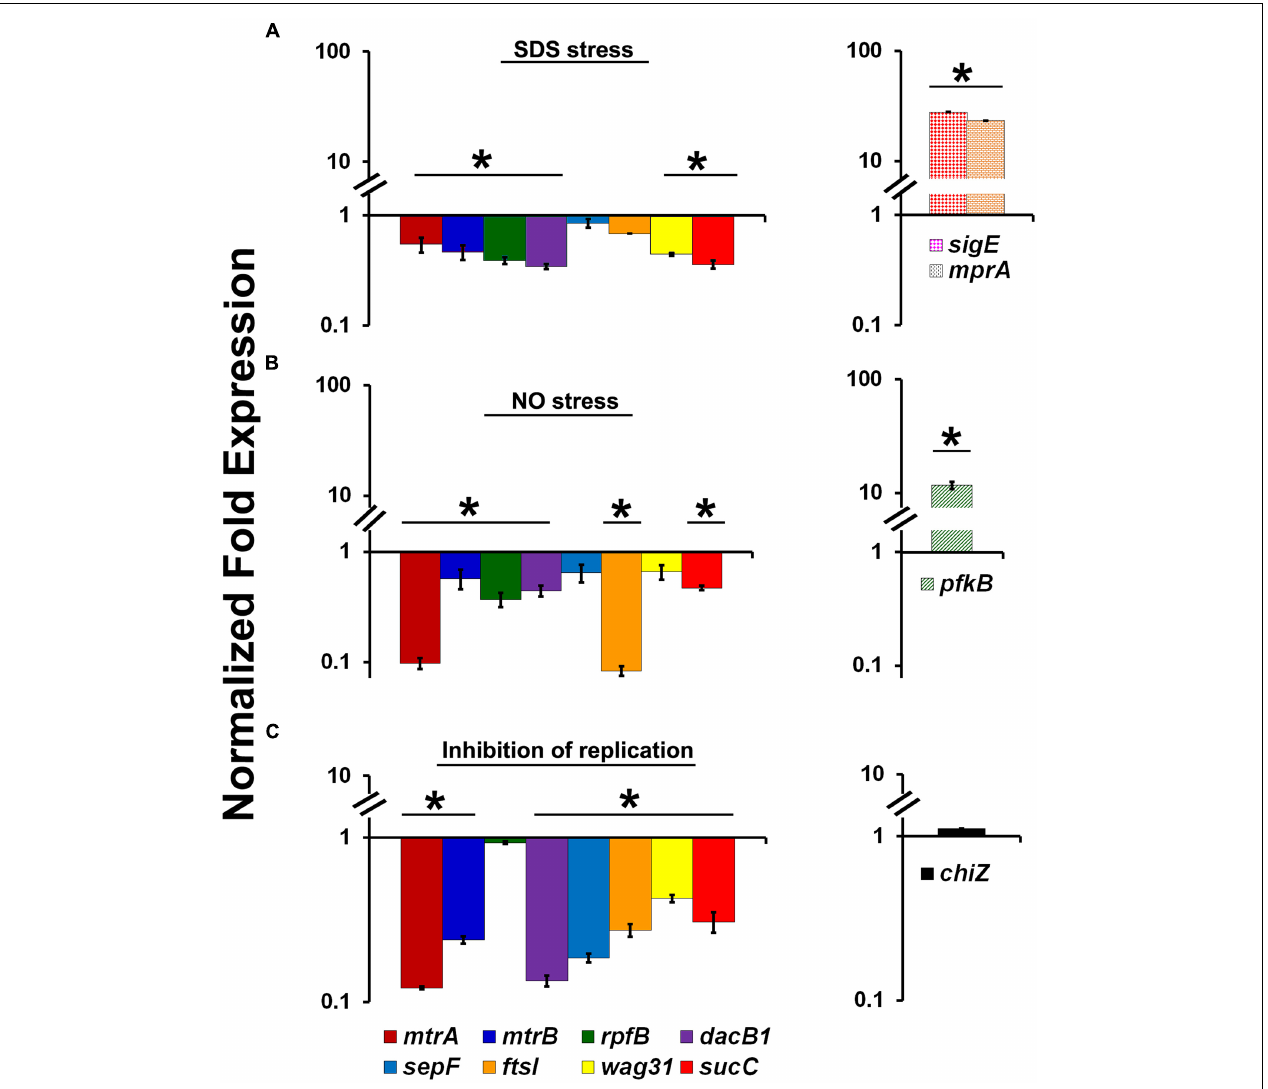
FIGURE 3 | Expression profiles of select MtrA target genes ( mtrA, mtrB , rpfB , dacB1 , sepF, ftsI , wag31, and sucC ) under stress and replication-arrest conditions. (A) Total RNA was extracted from actively growing M. tuberculosis cultures exposed to 0.2% SDS for 2 h and the expression levels were analyzed by qRT-PCR as described in Section “Materials and Methods.” (B) Total RNA was extracted from actively growing M. tuberculosis cultures exposed to 100 µ M DETA-NO for 16 h and qRT-PCR was performed to analyze gene expression profiles. (C) For evaluating the MtrA-target expression under replication inhibition conditions, M. tuberculosis dna A Ts cultures growing at permissive 37 ◦ C were shifted to 30 ◦ C and incubated for 30 h (non-permissive temperature). RNA samples prepared from cultures growing at both permissive and non-permissive temperatures were processed for evaluation of the target gene expression using qRT-PCR approach. The expression levels of selected genes at non-permissive temperature referred “Inhibition of replication” condition, relative to permissive temperature (37 ◦ C) are present on the graph. The qRT-PCR data are normalized to 16S rRNA levels. Mean values and standard deviations from three independent experiments are shown. Expression levels more than twofold was considered as significant upregulation and less than 0.5 fold as the significant reduction in gene expression of each target. Significant expression of each target or group of targets was marked with ‘ ∗ ’. The targets showed without ‘ ∗ ’ indicates no significant change in expression. The statistical analyses were performed using the Student’s t